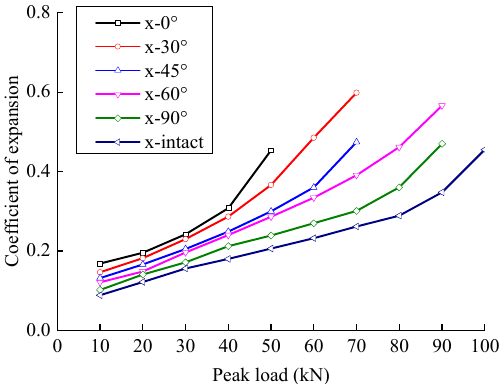
Figure 5. Relationship between the coefficient of expansion and load level.